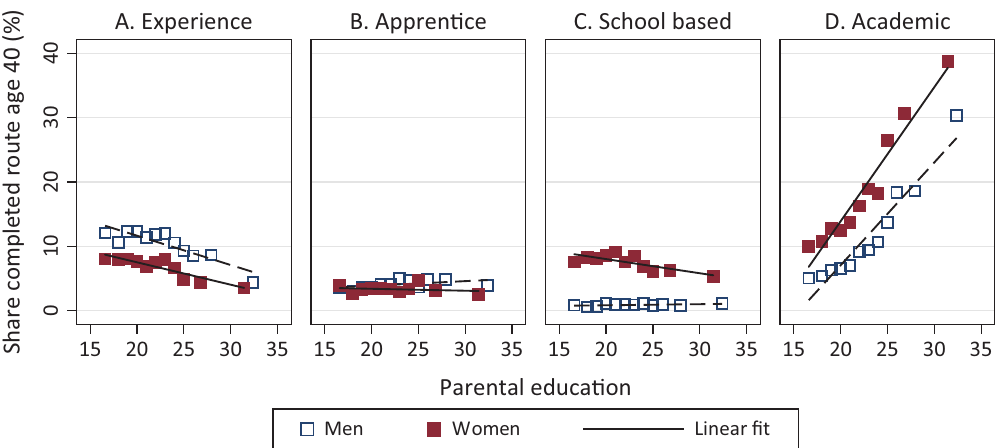
Figure 5. Adult completion of upper secondary education and parental education. Binned scatter plots by route of com- pletion. Note: Samples consist of dropouts age 25, observation counts are 29,960 men and 25,993